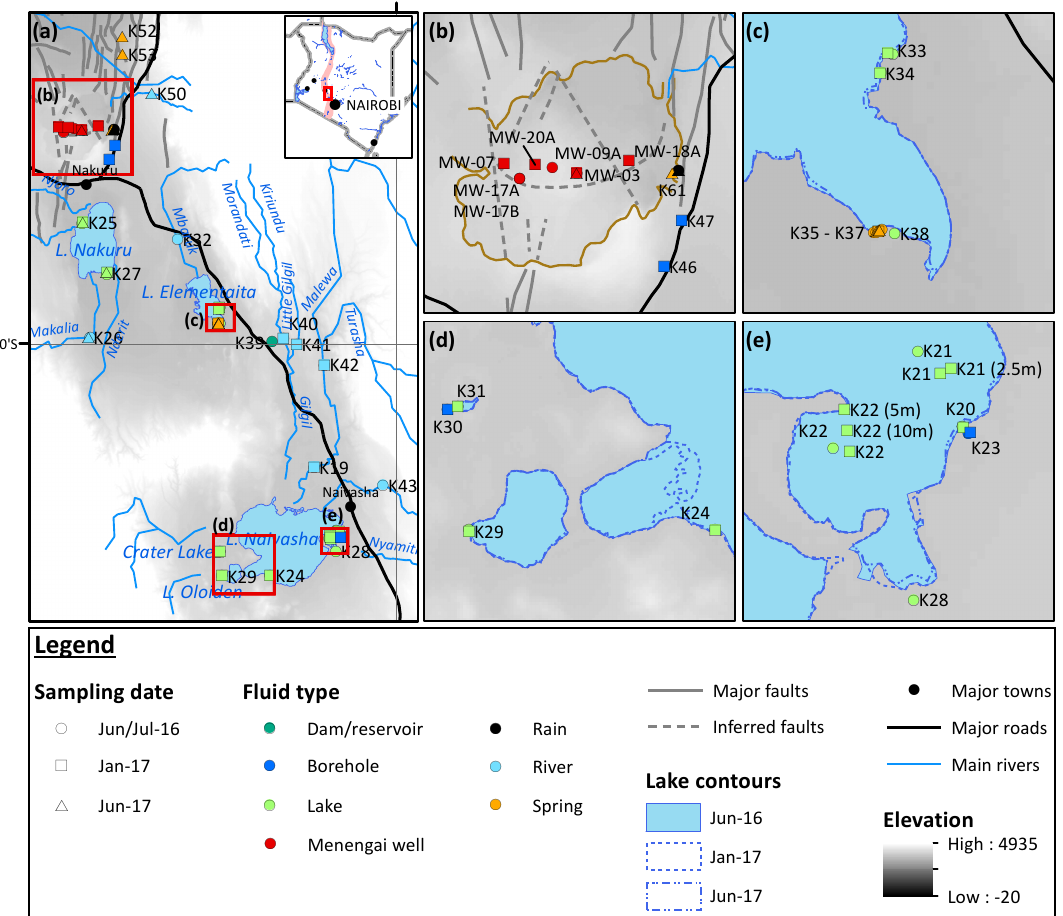
Figure 3. Locations of sampling points. ( a ) Entire study area; ( b ) Menengai Caldera; ( c ) Southeast shore of Lake Elementaita; ( d ) Southwest shore of Lake Naivasha, Lake Oloiden and Crater Lake; ( e ) East shore of Lake Naivasha. The faults were compiled from the available literature [17,33–35,42,44,54,56]. Lake shoreline indicators were digitised from Sentinel-2 and Landsat-1 satellite imagery [57] at the relevant